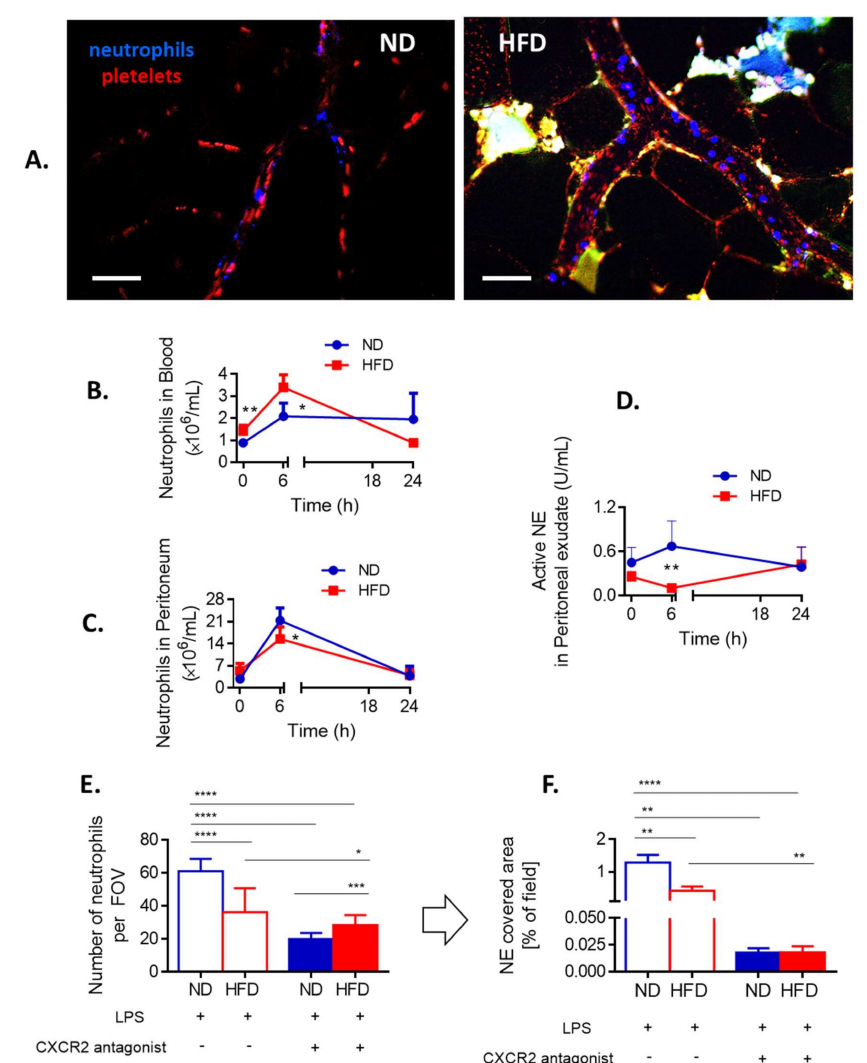
Figure 3. Neutrophil infiltration of the adipose tissue and peripheral tissues, and CXCR2-dependency of neutrophil accumulation in the sinusoids of lean (ND) and obese (HFD) mice. ( A ) Representative images of the vasculature in the adipose tissue of ND and HFD animals. To visualize blood flow, platelets were stained (red) and neutrophils labelled in blue. Autofluorescent adipose tissue is seen as white/green as the background signal. The scale bar indicates 50 µ m. Neutrophil counts in blood ( B ) and peritoneal lavage ( C ) were performed with a hemocytometer at different time points of endotoxemia. Additionally, neutrophil elastase (NE) activity was evaluated in the peritoneal exudate ( D ). To verify if neutrophil infiltration of liver sinusoids depends on a chemokine receptor CXCR2 some ND and HFD mice were pretreated with its antagonist (SB225002) and 24 h after induction of endotoxemia neutrophil infiltration ( E ) as well as neutrophil extracellular trap (NET) formation ( F ) in the liver vasculature were estimated. In E-F blue line/filling is always used for NDs and red for HFD mice. Asterisks indicate significant differences between lean (either ND or wt) and obese (either HFD or ob/ob) mice using unpaired two-tailed Student’s t -test (* p ≤ 0.05, ** p ≤ 0.01, *** p ≤ 0.001, **** p ≤ 0.0001). Data are shown as mean ± s.d.; n ≥ 3 per group. We attempted to detect NETs in the vasculature of the adipose tissue but no positive signal for any of their components was spotted at any time. We also verified numbers of neutrophils present in the blood (heart puncture). Although at first more neutrophils were detected in the peripheral blood (6 h) of obese individuals, at 24 h of sepsis their numbers were lower than those found in lean animals (Figure 3B). Thus, at the latter time point the pattern was the same as in liver sinusoids (Figure 2B). Importantly, we verified that also at 6 h of endotoxemia neutrophils of obese individuals were releasing less NETs than those of lean mice despite higher neutrophil counts (Supplementary Figure